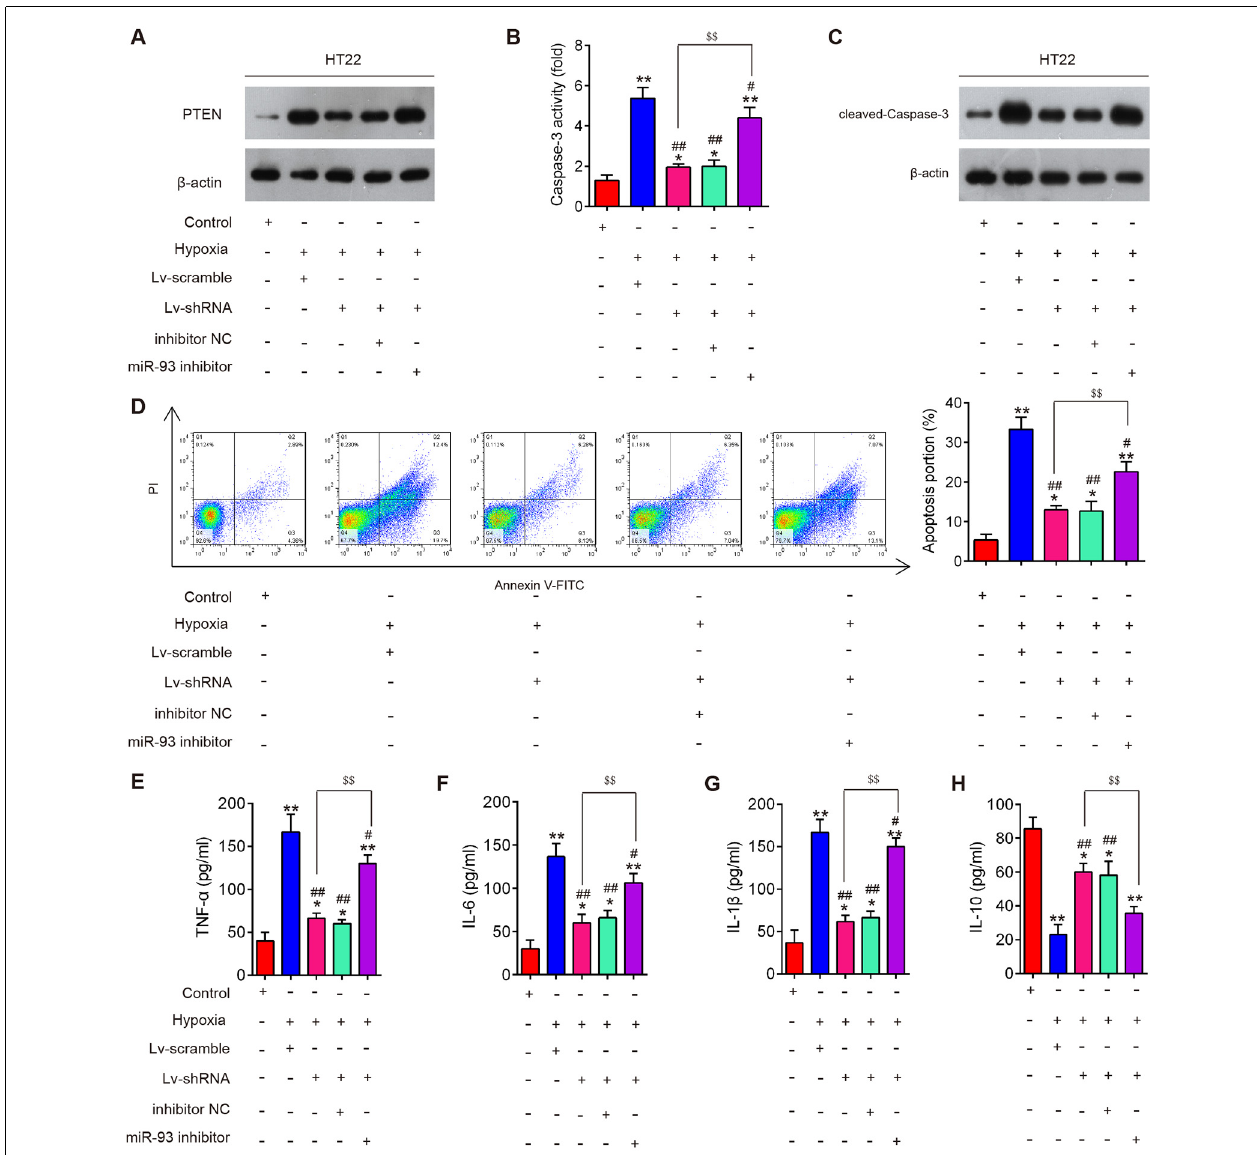
FIGURE 7 | Silencing of long noncoding RNA (lncRNA) growth arrest–specific transcript 5 (GAS5) reduced apoptosis and inflammation by regulating miR-93 in vitro . HT22 cells were cotransfected with lentivirus short-hairpin RNA (LV-shRNA) and miR-93 inhibitor in HT22 cells, followed by hypoxia treatment. (A) The expression of phosphatase and tensin homolog (PTEN) in HT22 cell extracts in different groups was measured using Western blotting. (B) The activity of caspase-3 was measured using a caspase-3 activity assay kit. (C) Protein expression of cleaved caspase-3 was measured using Western blotting. (D) The percentage of apoptotic neuronal cells was detected using flow cytometry. (E–H) Levels of tumor necrosis factor (TNF)- α , interleukin (IL)-6, IL-1 β , and IL-10 in neuronal cells were measured using enzyme-linked immunosorbent assay. Data represent the mean ± SD of three independent experiments. * p < 0.05, ** p < 0.01 vs. control group; # p <